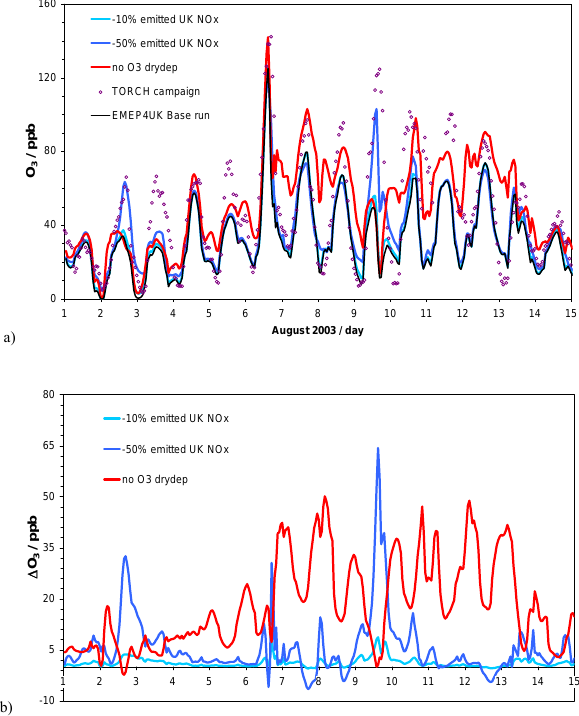
Figure 13: As for Figure 8 but for model sensitivity experiments with -10% (pale blue) and - Fig. 13. As for Fig. 8 but for model sensitivity experiments with 50% (blue) UK anthropogenic NO x emissions and with zero O 3 dry deposition (red). − 10% (pale blue) and − 50% (blue) UK anthropogenic NO x emis- sions and with zero O 3 dry deposition